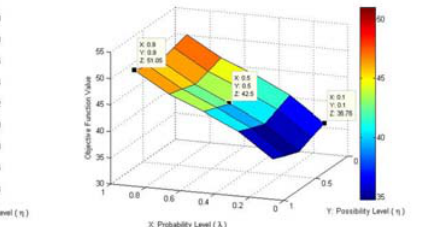
Fig. 7. hybrid optimal solutions for lowest, middle and highest levels of , 